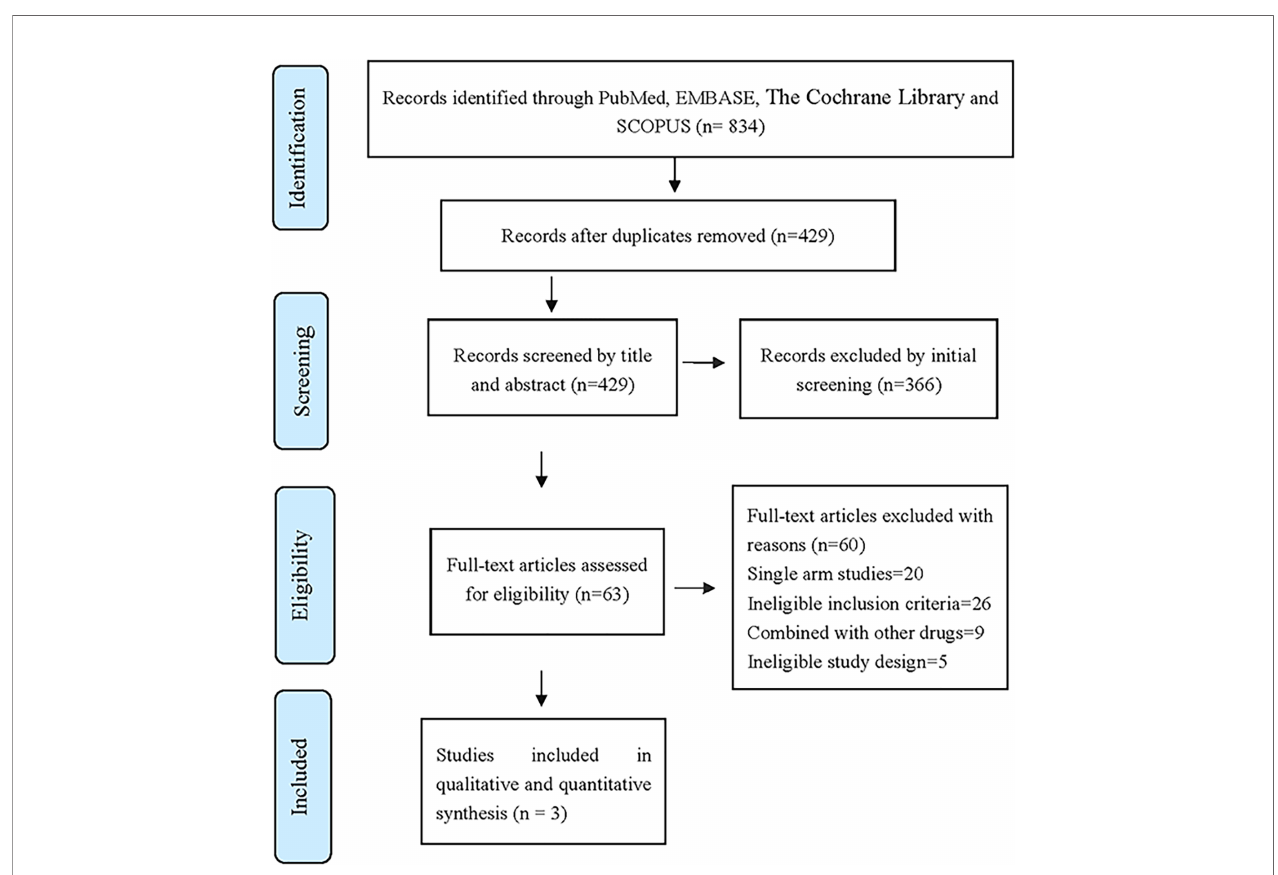
FIGURE 1 | The database retrieved by 834 articles and the number of documents detected are as follows: PubMed (n = 158), Embase (n = 360), Scopus (n = 270), The Cochrane Library (n = 46).